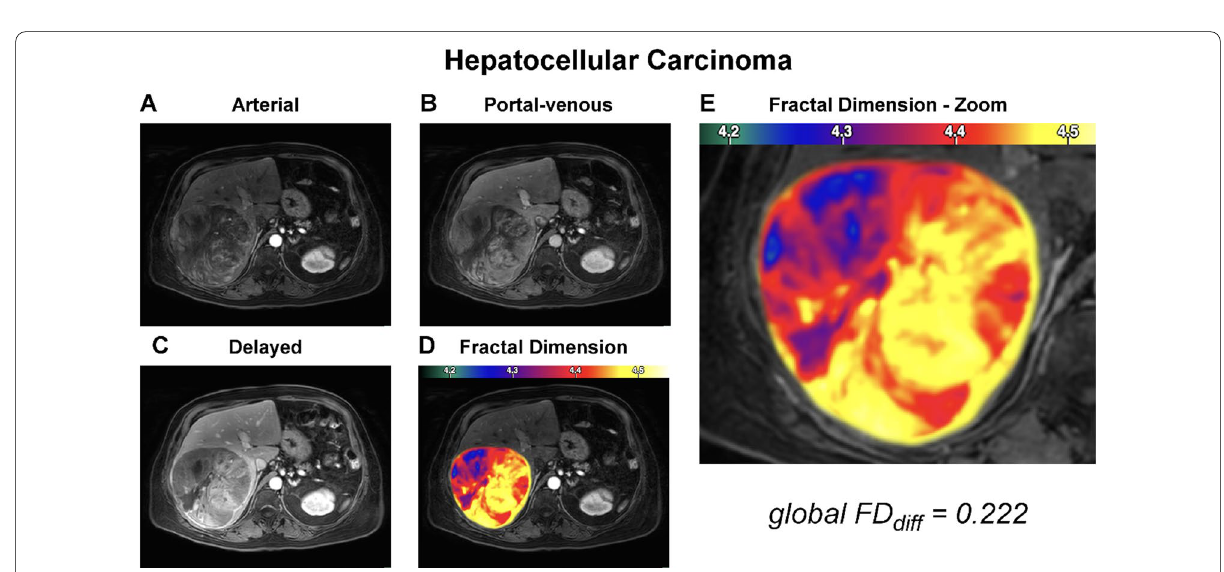
Fig. 5 Representative case of hepatocellular carcinoma. The panel organization is the same throughout Figs. 2, 3, 4, and 5. The depicted patient was a 42-year-old man without symptoms, admitted for exploration of a liver lesion and elevated alpha-fetoprotein. MRI features with arterial phase hyperenhancement, washout, and enhancing capsule suggested hepatocellular carcinoma, confirmed by biopsy and subsequently resected specimen. Remote liver tissue showed no